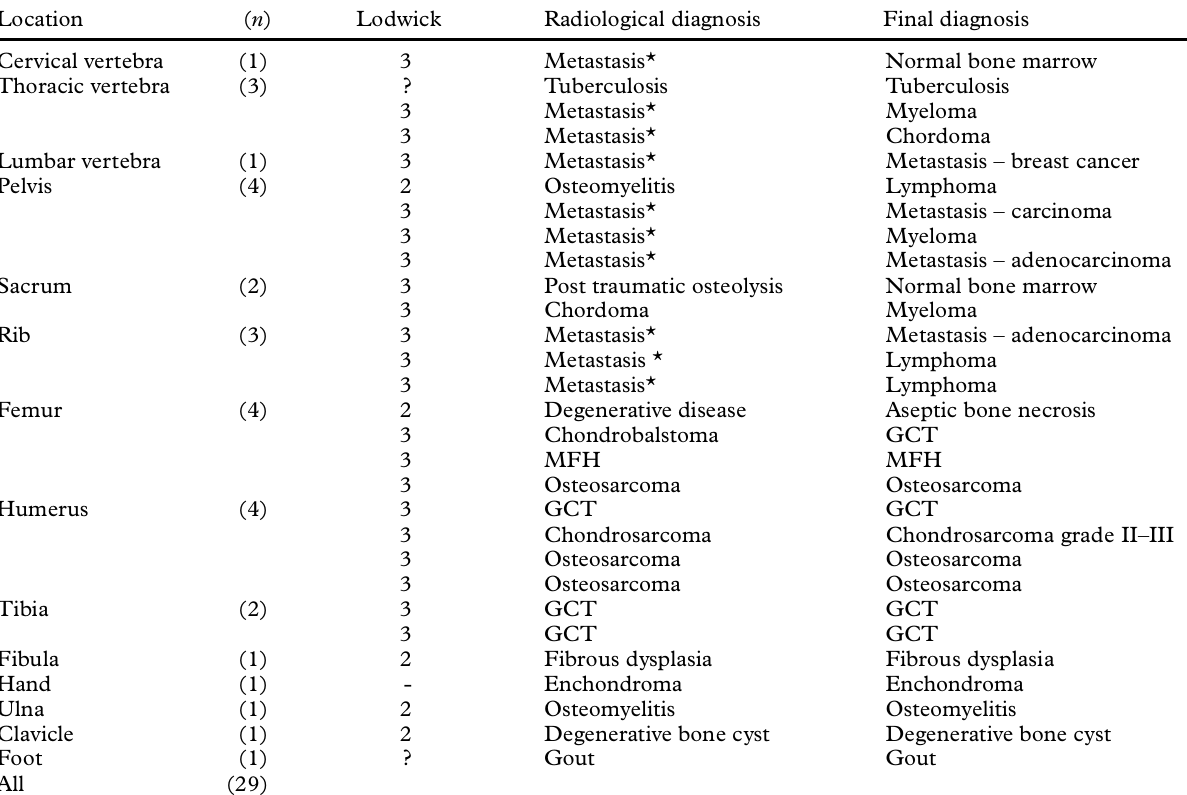
Table 1. The site of the 29 lesions, tentative radiological diagnosis and (cid:142) nal diagnosis